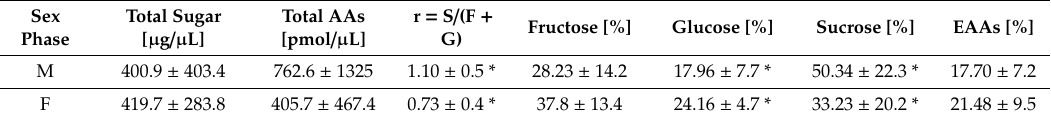
Figure 1. Mean percentage of nectar sugars in populations of Polemonium caeruleum from three regions in Poland. The sample number for each region was, respectively, n = 18 for the northeastern (NE) populations, n = 7 for the northern (N) populations, and n = 4 for the southern (S) populations. The line in the middle of the box represents the median and the circle represents the mean. Boxes extend from the 5th to 95th percentiles. There were no significant differences in sugar percentages between regions ( p > 0.05). Table 2. Nectar characteristics during male (M) and female (F) sexual phases of Polemonium caeruleum flowers. Total sugar and amino acid (AA) concentration, r (sucrose/hexose ratio), percentage of three main sugars (fructose, glucose, and sucrose), and essential amino acids (EAAs: phenylalanine, leucine, arginine, threonine, lysine, isoleucine, valine, methionine, histidine, and tryptophan). Data represent mean values for nectar obtained from flowers in male and female sexual phases, from 14 populations ± SD, n = 15 for the male phase, n = 14 for the female phase. Significant differences between M and F sexual phases are marked with * at p < 0.05.